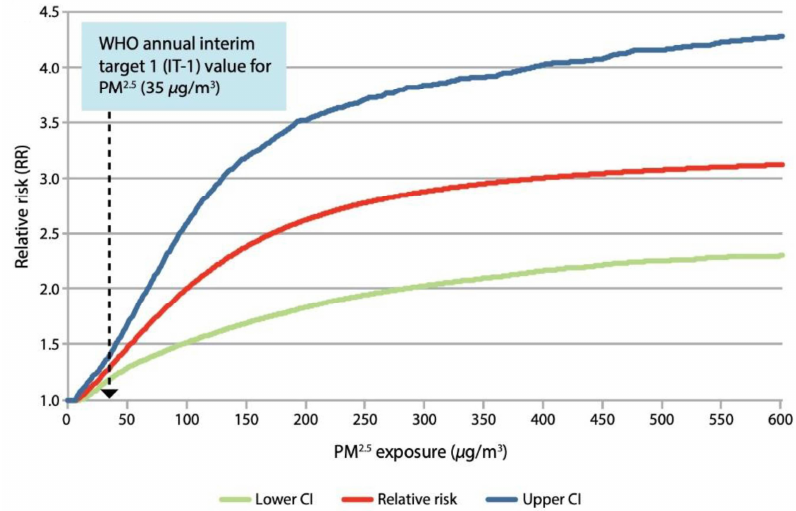
Figure 1. Relationship between the level of PM 2.5 exposure ( µ g/m 3 ) and the relative risk (95% CI) of child ALRI, based on the integrated exposure–response function, for exposure over the range 0–600 µ g/m 3 . Source: WHO (2014) WHO Guidelines for Indoor Air Quality. Geneva. Household Fuel Combustion. p. 43. https://apps.who.int/iris/handle/10665/141496 (last accessed on 30 August 2021) CC BY-NC-SA 3.0